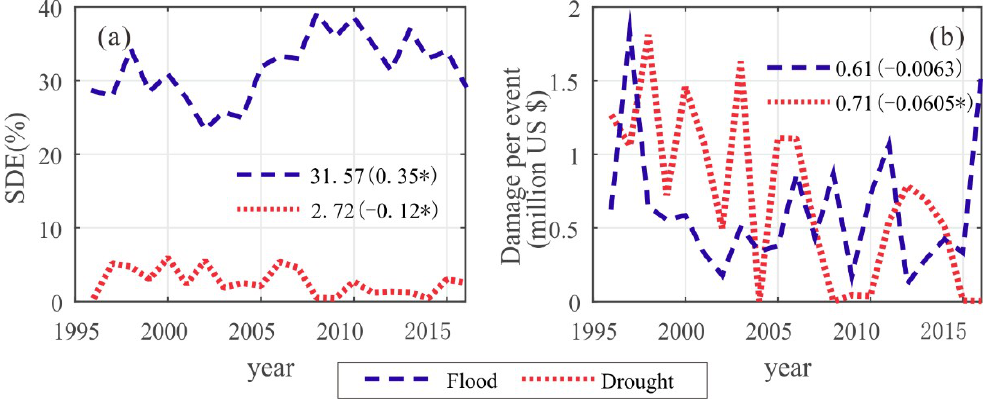
Figure 3. Changes in ( a ) the share of events causing damage (SDE) and ( b ) damage per event (DPE) by floods and droughts during 1996–2016. The numbers indicate the long-term mean annual values and changing trends, respectively. The trends that are statistically significant at the 90% confidence level are highlighted with asterisks (*).